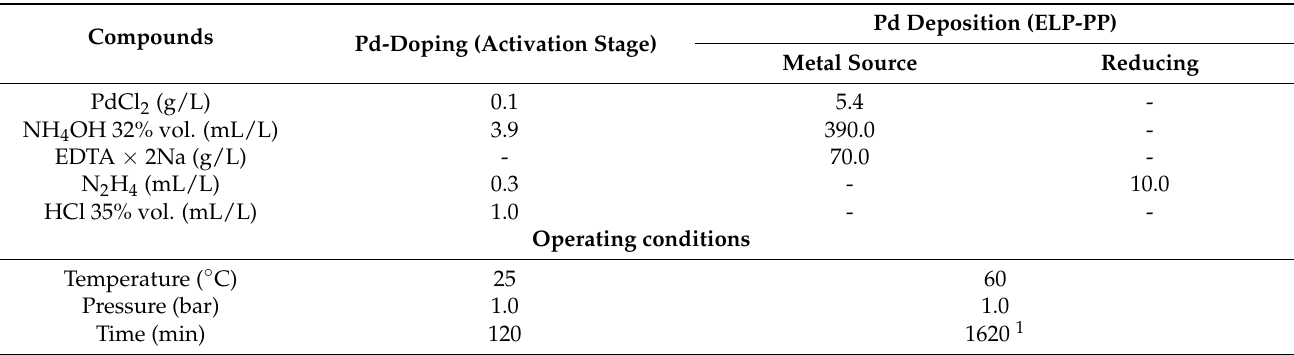
Table 1. Operating conditions and composition in solutions used for both Pd-doping of CeO 2 particles and Pd-deposition by